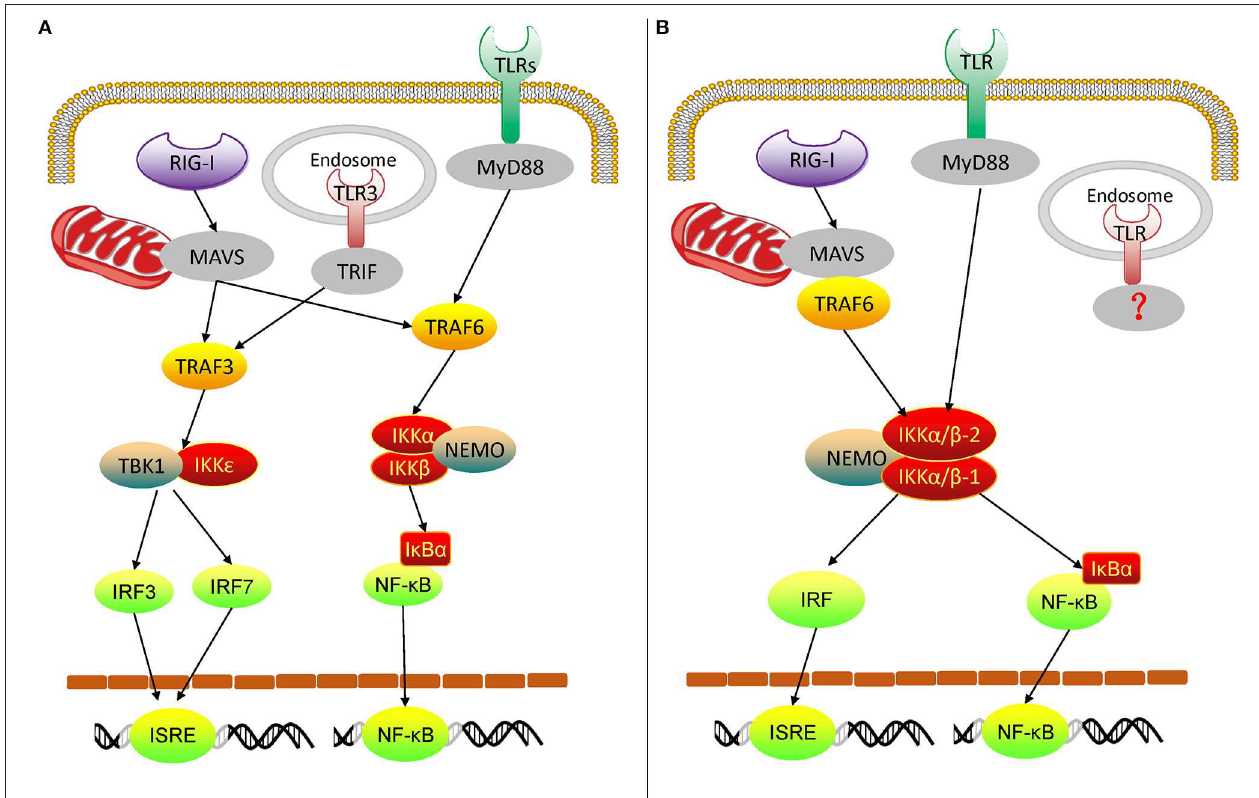
FIGURE 10 | Diagram of vertebrate TLR and RLR signaling (A) and oyster TLR and RLR signaling (B) . TRIF, TIR-domain-containing adapter inducing interferon- β